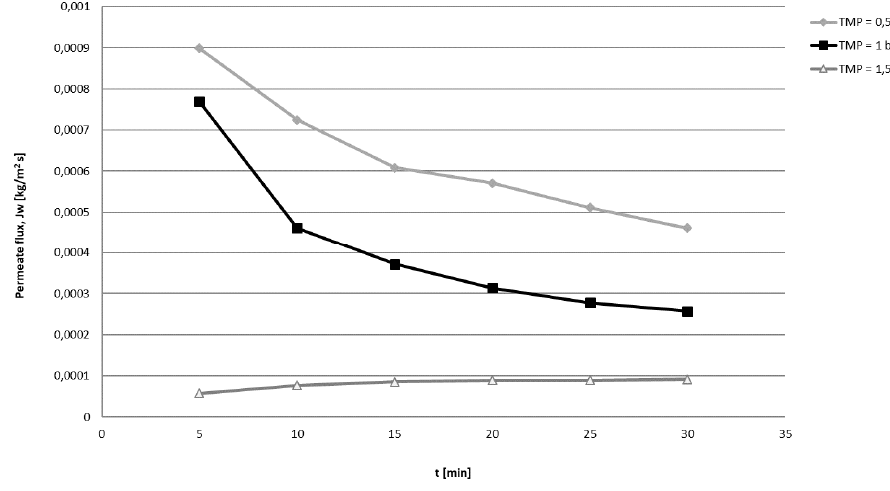
Figure 1. Permeate flux as function of time at different TMP.